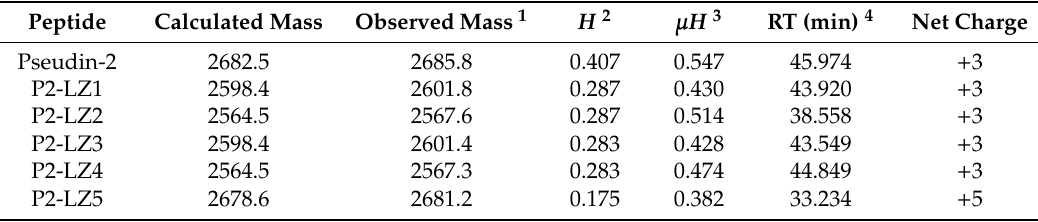
Table 1. Physicochemical characteristics of pseudin-2 and its